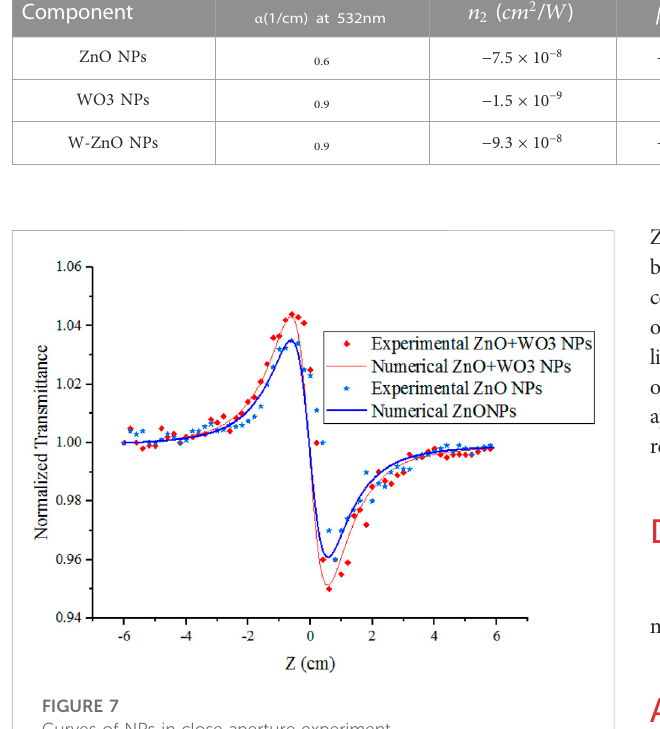
FIGURE 7 Curves of NPs in close aperture experiment.